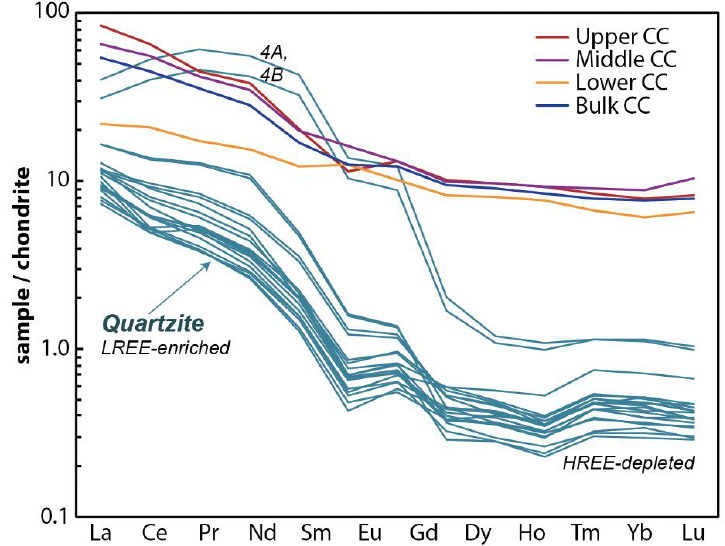
Figure 8. Normalization [37] of Kinnikinic Quartzite samples to chondrite. Normalizing values from Nakamura, 1974. For comparison, Earth’s bulk geochemical reservoirs are also shown. Data from Rudnick and Gao (2003). As shown, the sampled Kinnikinic Quartzite is significantly depleted by 1–3 orders of magnitude in REEs compared to Earth’s crustal values. See text for discussion.